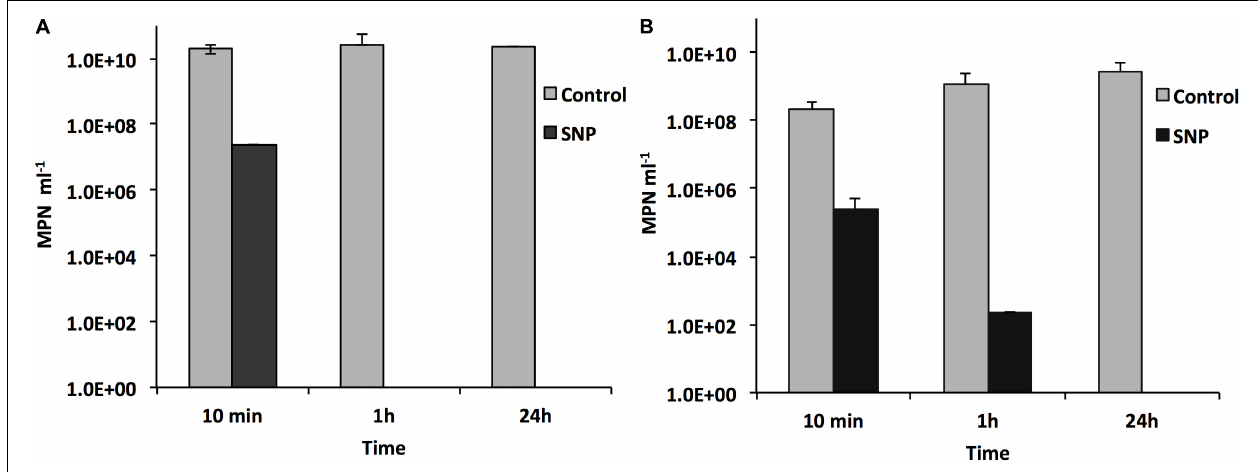
FIGURE 4 | Effect of SNP on the MPNs for SRB and APB in an anaerobic consortium. The MPNs of SRB (A) and of APB (B) after 10 min, 1 h, and 24 h of exposure of an actively growing consortium to 0.5 mM SNP (black bars) are compared with the MPNs for the same consortium not exposed to SNP (gray bars).